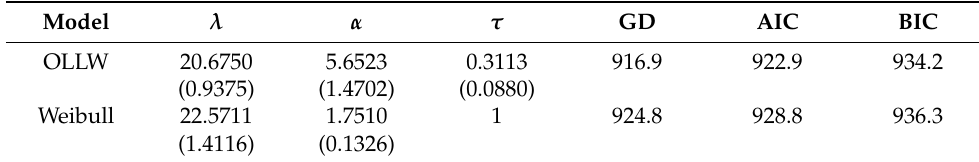
Table 3. Estimation results.